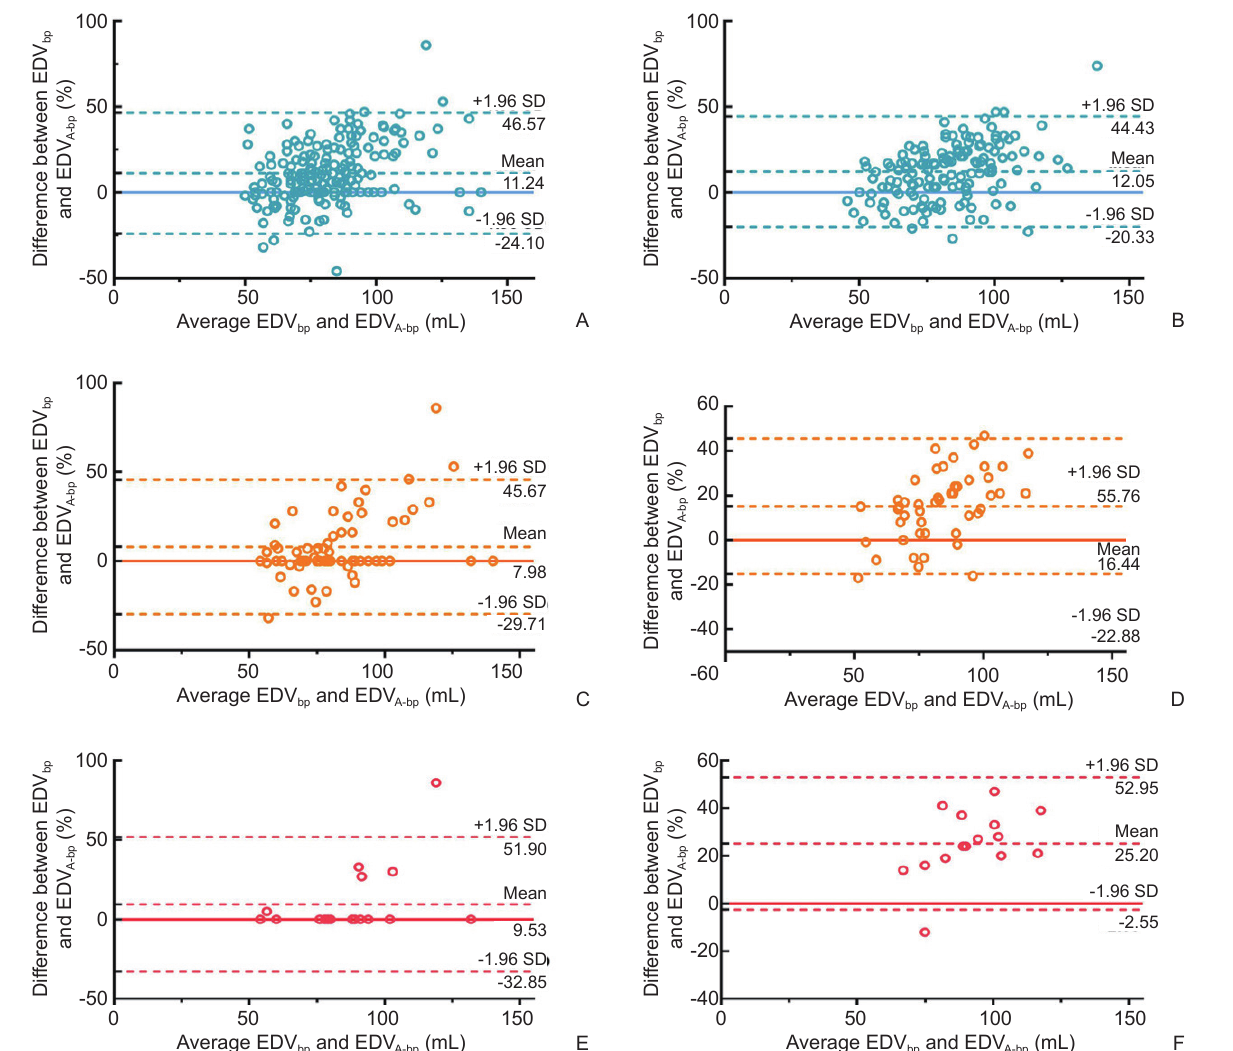
Figure 7 Bland–Altman analysis of EDV between different methods in different image quality group. (left) The good quality group and (right) poor quality group for manual EDV vs. automated EDV in the common group (A and B), CHD group (C and D), WMA group (E and F). CHD, cardiac heart disease; WMA, wall motion abnormalities; EDV, end-diastolic volume; EDV bp was parameter by manual method; EDV A-bp was parameter by automated